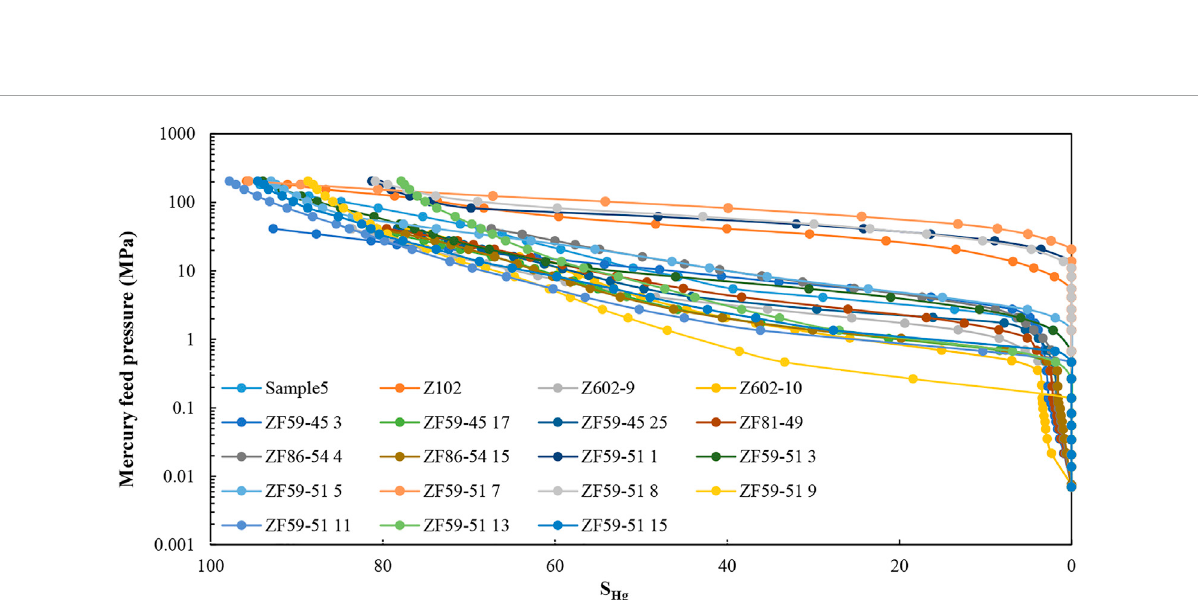
FIGURE 9 Mercury injection curve of corethe.